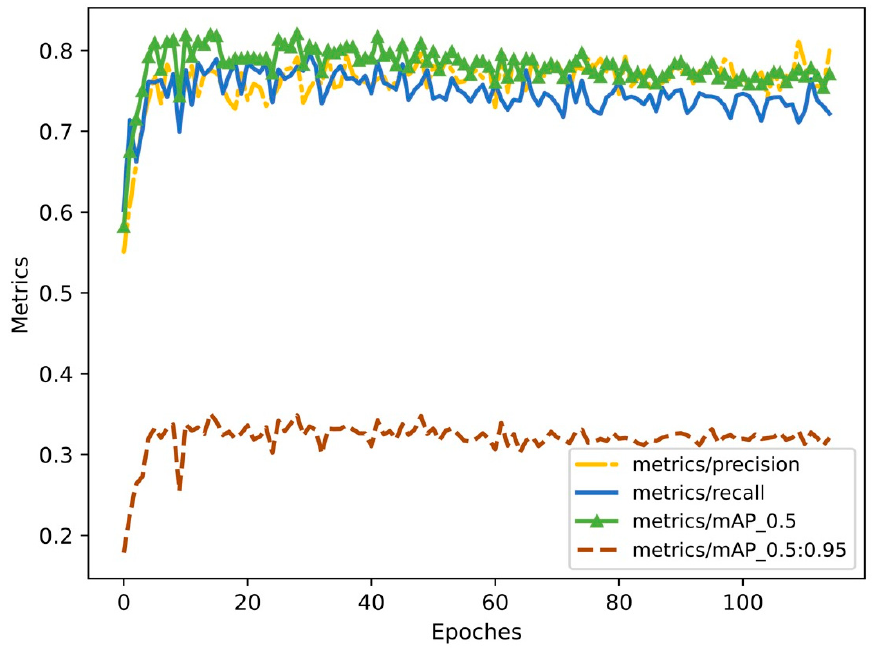
Figure 5. The curves of metrics per training epoch.